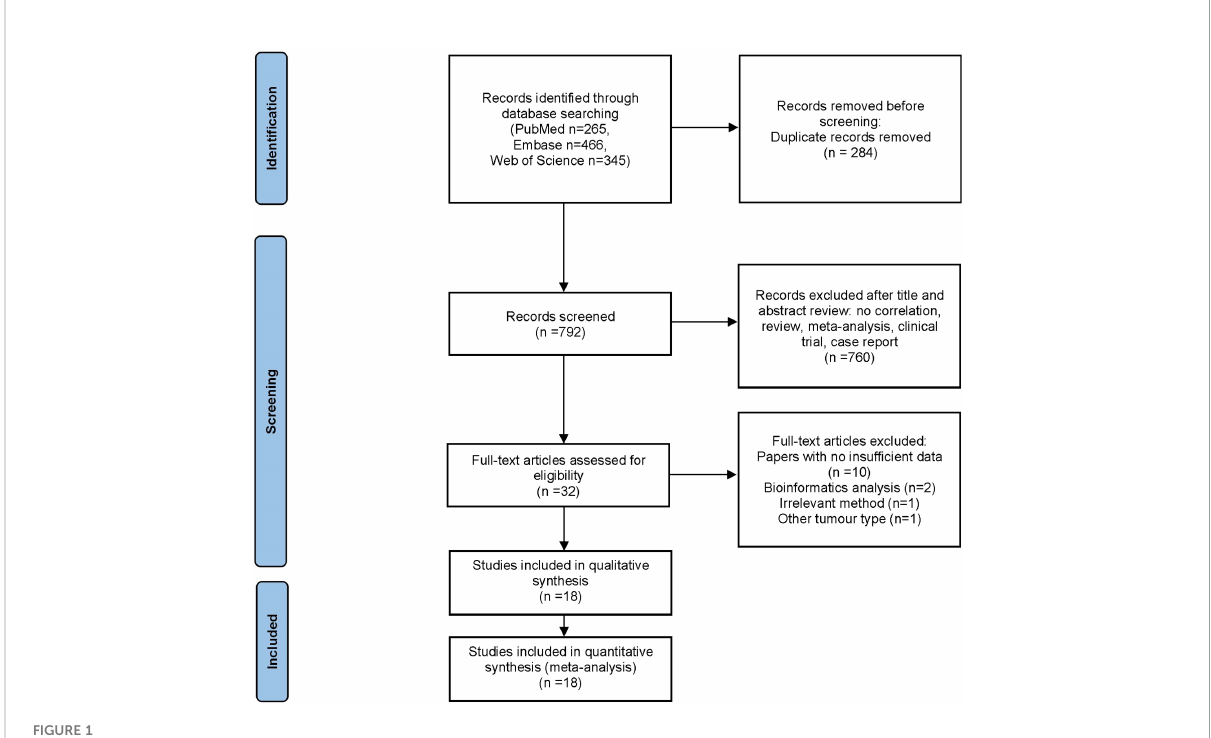
FIGURE 1 Flow diagram of study